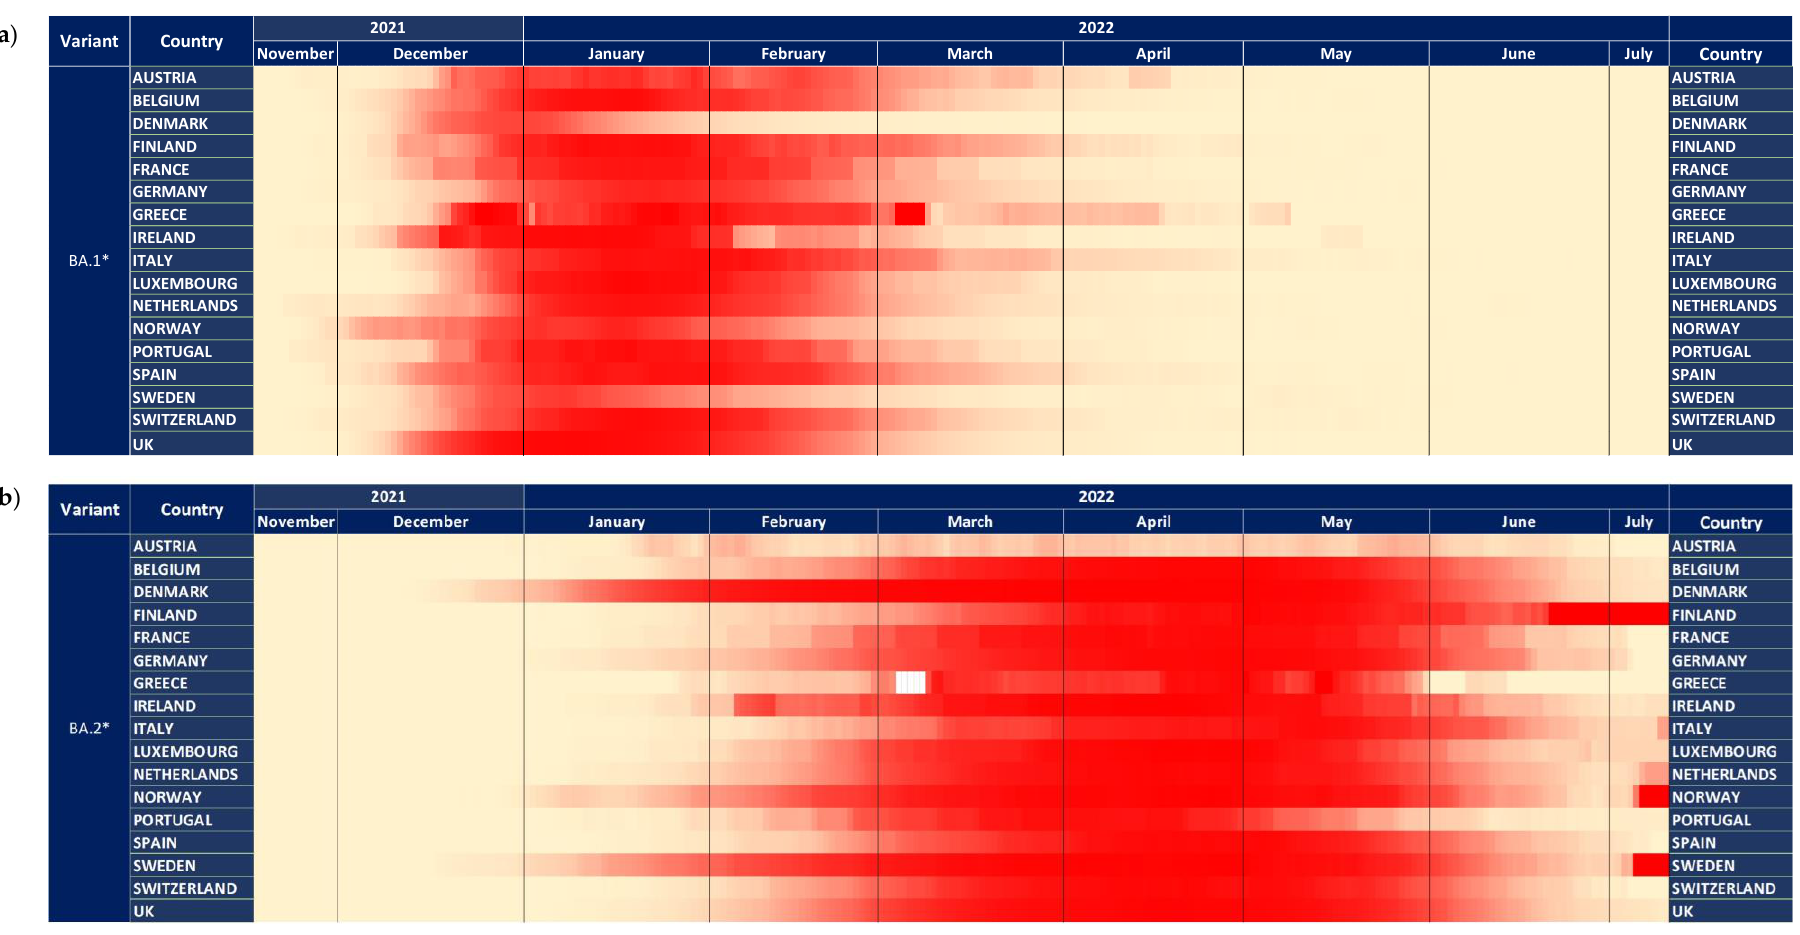
Figure 2. The dynamics of variants across 17 European countries shown with heatmaps representing the proportion of all samples. Heatmap shown with a maximum of 100% ( a ) BA.1* variants ( b ) BA.2* variants